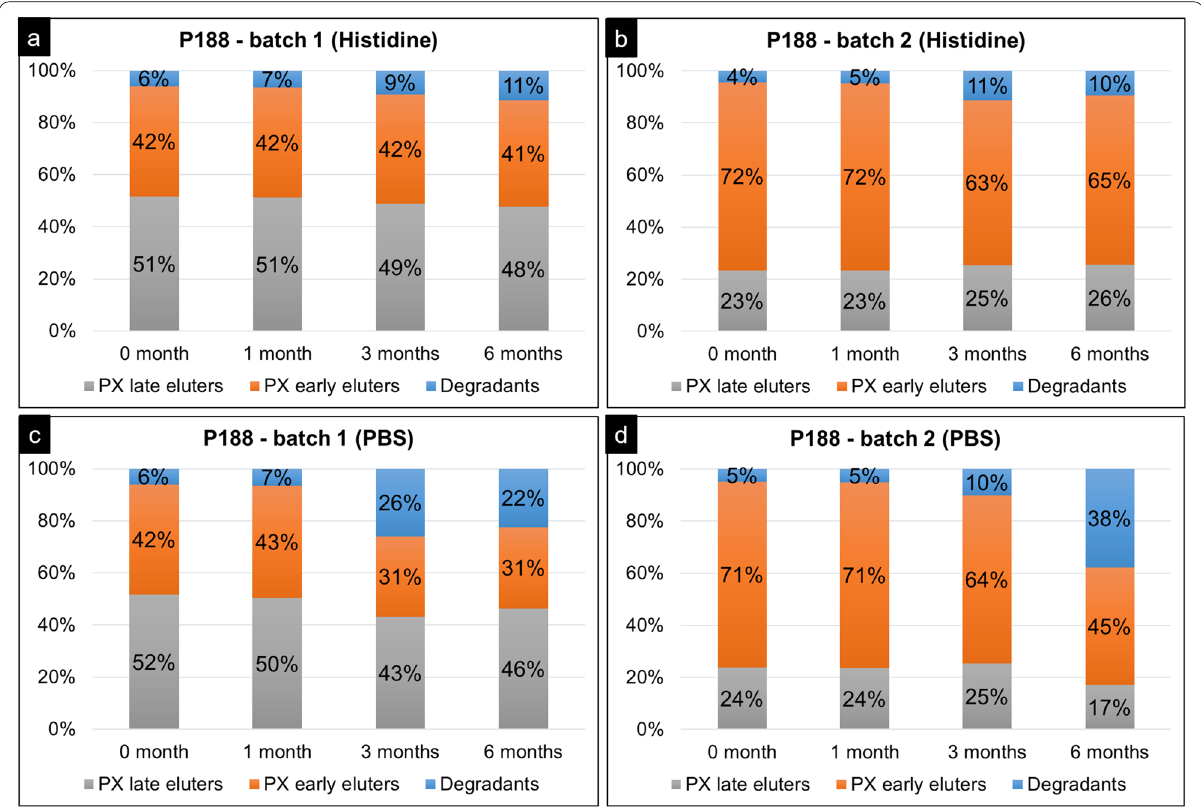
Fig. 5 The degradation of P188 at 40 °C in histidine ( a , b ) and PBS buffers ( c , d